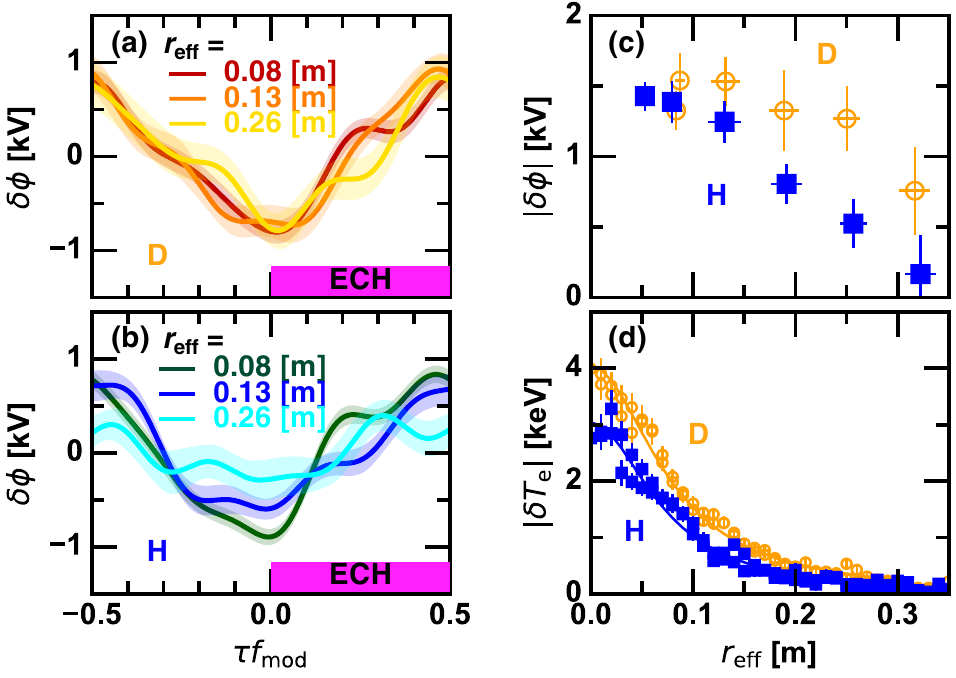
Figure 6. Conditionally averaged electrostatic potentials at various radii for ( a ) deuterium plasmas and ( b ) hydrogen plasmas; and radial profiles of the peak-to-peak modulation amplitude in ( c ) the electrostatic potential and ( d ) the electron